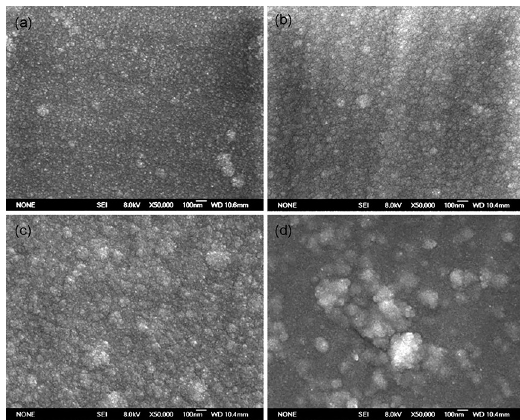
Figure 4: FESEM morphology of the coatings at different times under 80W plasma power. (a) 10 minutes, (b) 20 minutes, (c) 40 minutes, (d) 60 minutes.